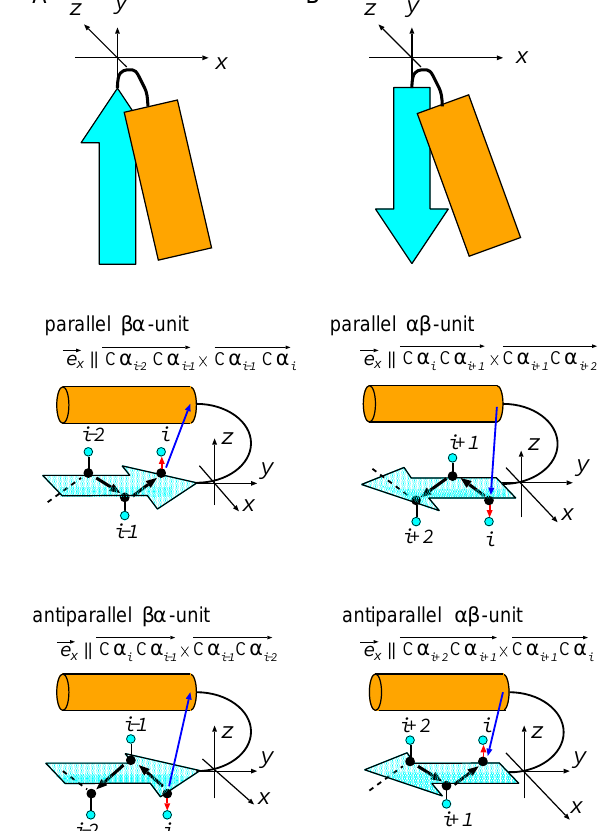
Figure 7. The xyz -coordinate system to define the distance x between the plane of β -pleats and the α -helix. ( A ) The βα -unit and ( B ) the αβ -unit. These units consist of a β -strand (cyan arrow) and an α -helix (orange rectangle). Top panels represent the rough sketch of the coordinate system. Middle and bottom panels show C α atoms (black dots), C β atoms (cyan dots), a vector spanning from the C α to the C β of the terminal residue of the β -strand (i.e., the residue in the strand nearest to the helix) in each unit (red arrow), and a vector spanning from the C α of the terminal residue of the β -strand to the center of mass of terminal four residues of the α -helix (i.e., four residues in the helix nearest to the strand) in each unit. Unit is referred to as “parallel” when the inner product of red and blue arrows is positive, and as “antiparallel” when the inner product is